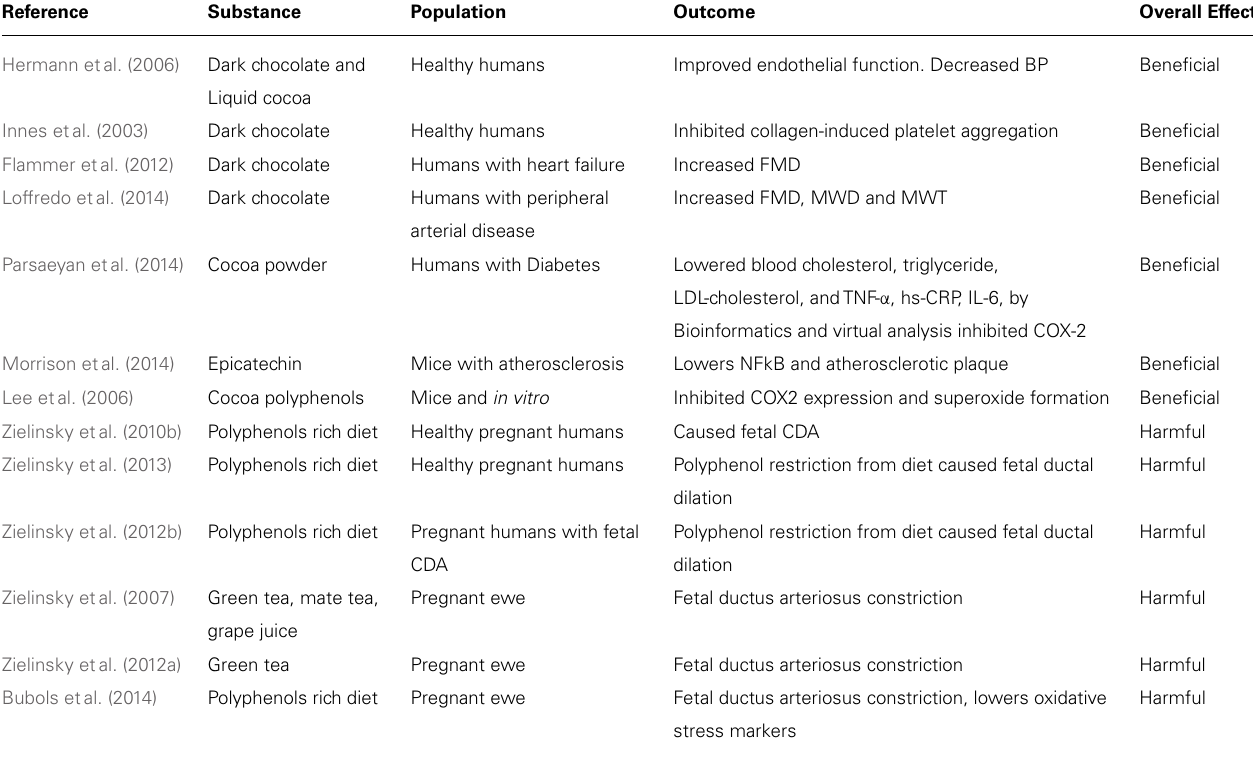
Table 1 | Effect of Cocoa, chocolate and polyphenol rich substances and their beneficial effect on the adult or harmful effect on the